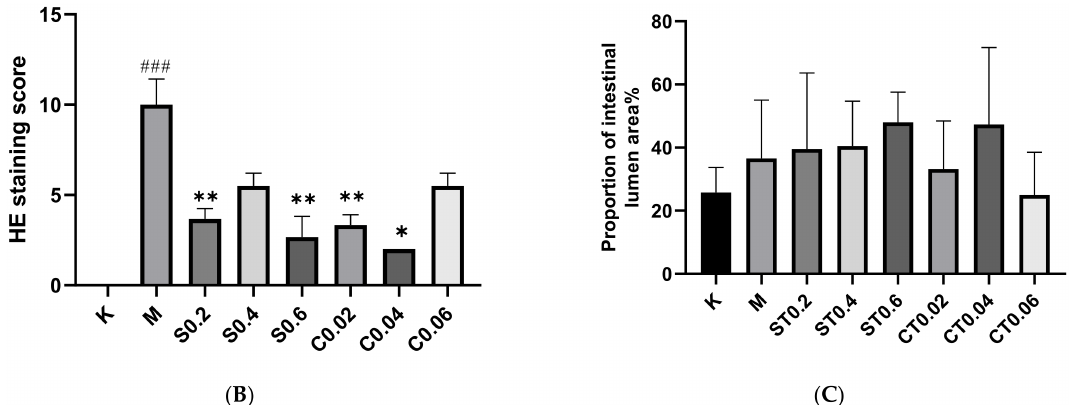
Figure 2. HE staining results and the proportion of intestinal lumen area in cross-sectional sections of zebrafish intestine in the blank, model and dosing groups. ( A ) HE staining map of zebrafish intestine. The red circle indicates the zebrafish gut section, and the yellow arrow indicates the broken intestinal epithelium. ( B ) Results of zebrafish intestinal HE staining score ( n = 3). ( C ) The proportion of intestinal lumen area occupied by zebrafish. K: blank control group; M: model group; ST (0.2, 0.4, 0.6): water extract from chrysanthemum stem and leaf (0.2, 0.4, 0.6 mg/mL); CT (0.02, 0.04, 0.06): alcohol extract from chrysanthemum stem and leaf (0.02, 0.04, 0.06 mg/mL). (Model group vs. control group: ### p < 0.001; drug administration group vs. model group: * p < 0.05, ** p < 0.01).